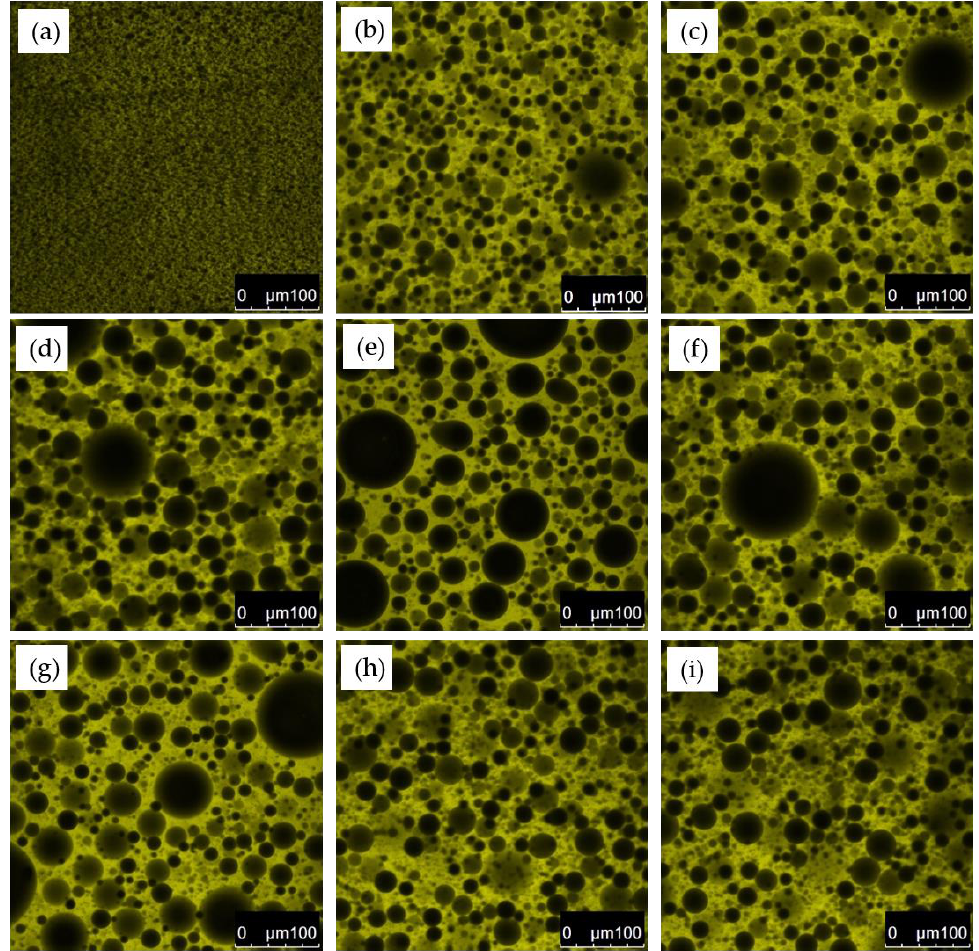
Figure 6. LSCM photographs of epoxy asphalt samples with different curing times (60 °C): (a) 0 h, (b) 0.5 h, (c) 3 h, (d) 5 h, (e) 12 h, (f) 24 h, (g) 48 h, (h) 72 h, and (i) 96 h.